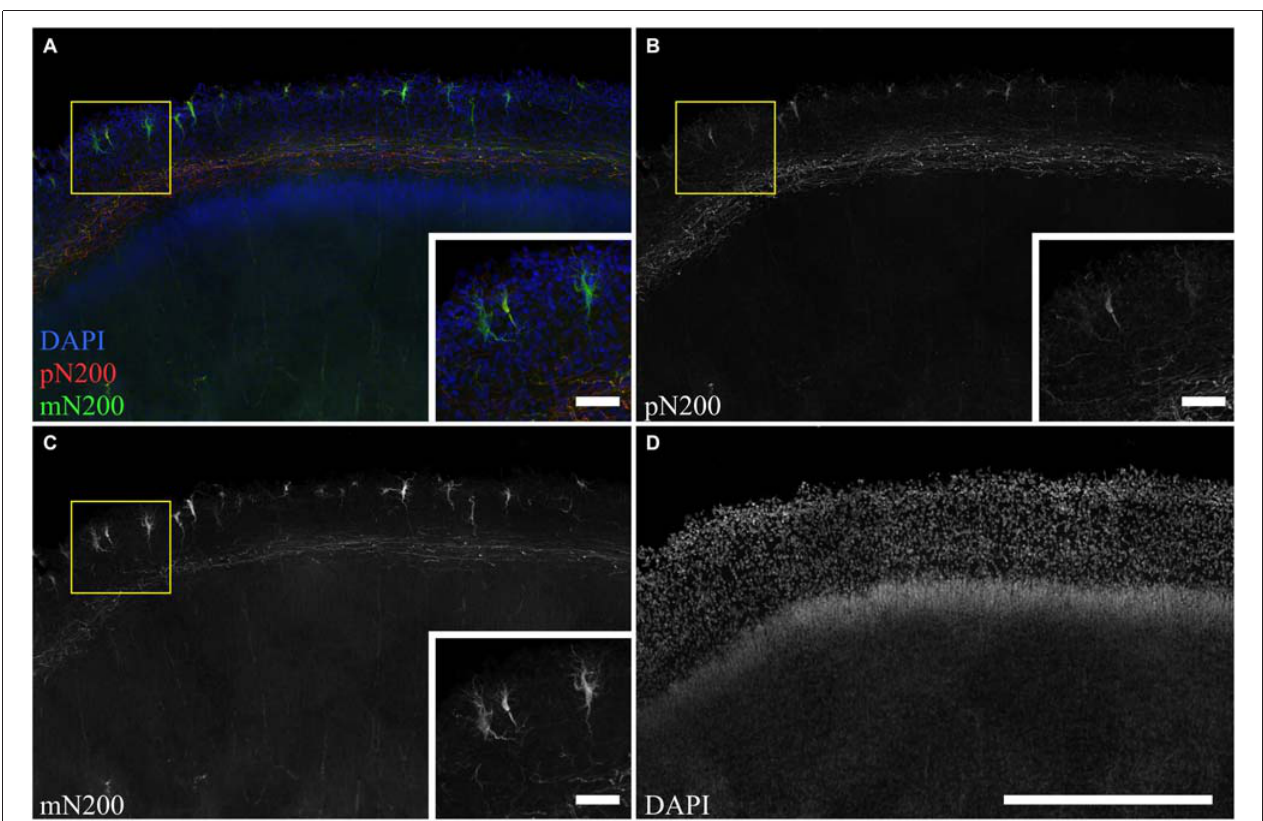
FIGURE 3 | The difference in C–R cells and plexus immunostaning in the MZ for poly- and monoclonal anti-N200 antibodies. (A–D) Photomicrograph of slice stained with pN200 (red), mN200 (green), DAPI (blue). Box shows the position of the area given at a higher magnification in inserts. Scale bars: (D) 500 µ m; inserts in (A–C) 50 µ